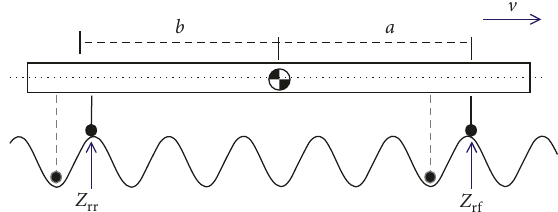
rf and Z rr . Both cases scarcely